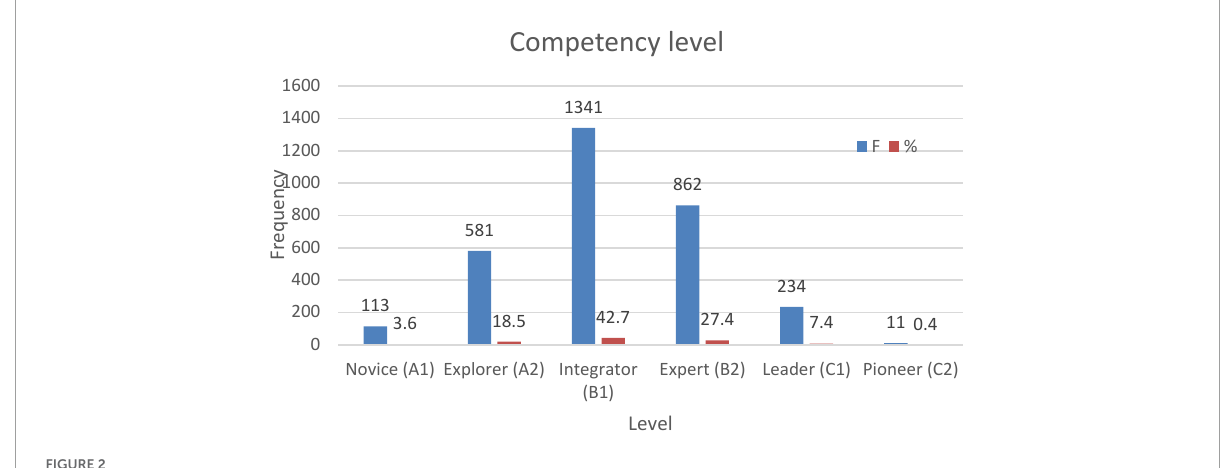
FIGURE2 Levels of digital teaching competence of the participants. Score based on the global classification of teaching digital competence by Cabero-Almenara and Palacios-Rodríguez